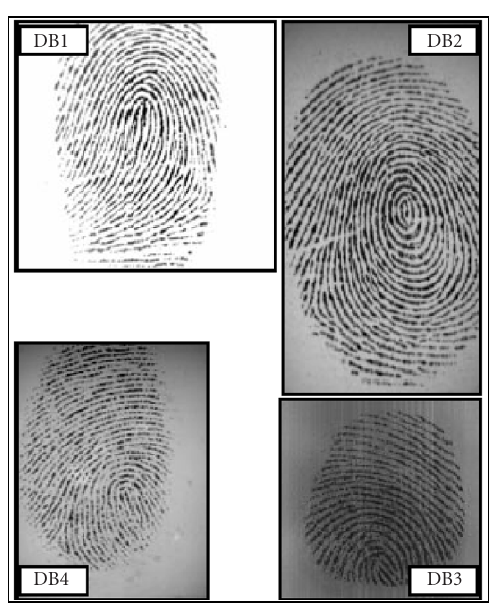
Figure 2: One fingerprint image from each